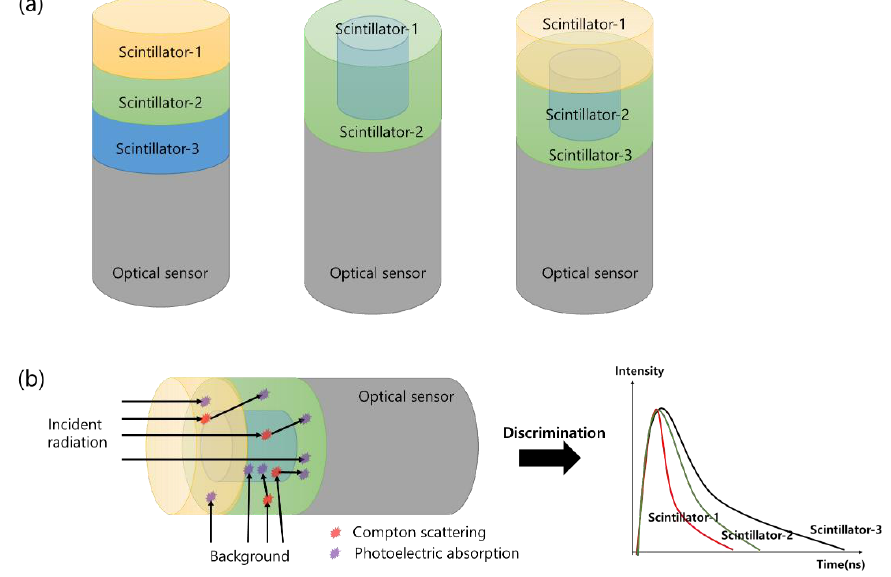
Figure 2. Example of a Phoswich structure ( a ) and example of signal classification method ( b ).